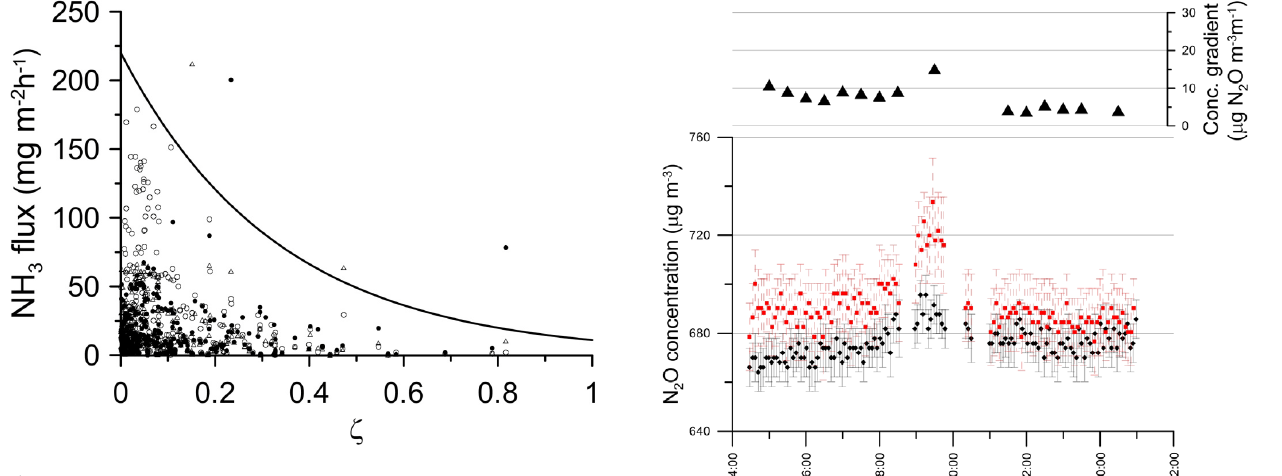
Fig. 8. The relationship between the computed fluxes and stability ς using flux-gradient method following a “similarity” approach (open circles), the flux-gradient method assuming a MOST parameterized stability correction function ψ c (“parameterized” approach, closed circles), and the flux-gradient method using measured friction ve- locity u ∗ (“measured u ∗ ” approach, triangles) are indicated. Three extreme outlier values of the parameterized method are not plotted. The line shows the upper emissions bound.